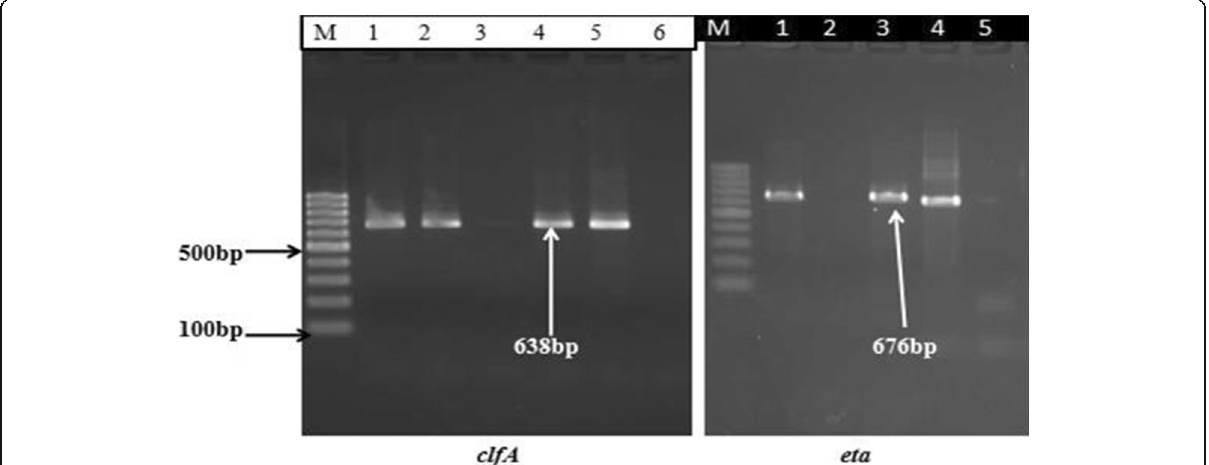
Fig. 2 Agarose gel electrophoresis of PCR amplicon of clfA and eta genes of representative S. aureus isolates . Lane M is a 1000-bp DNA marker (DNA ladder, Bio Basic); lanes 1 to 6 are test samples